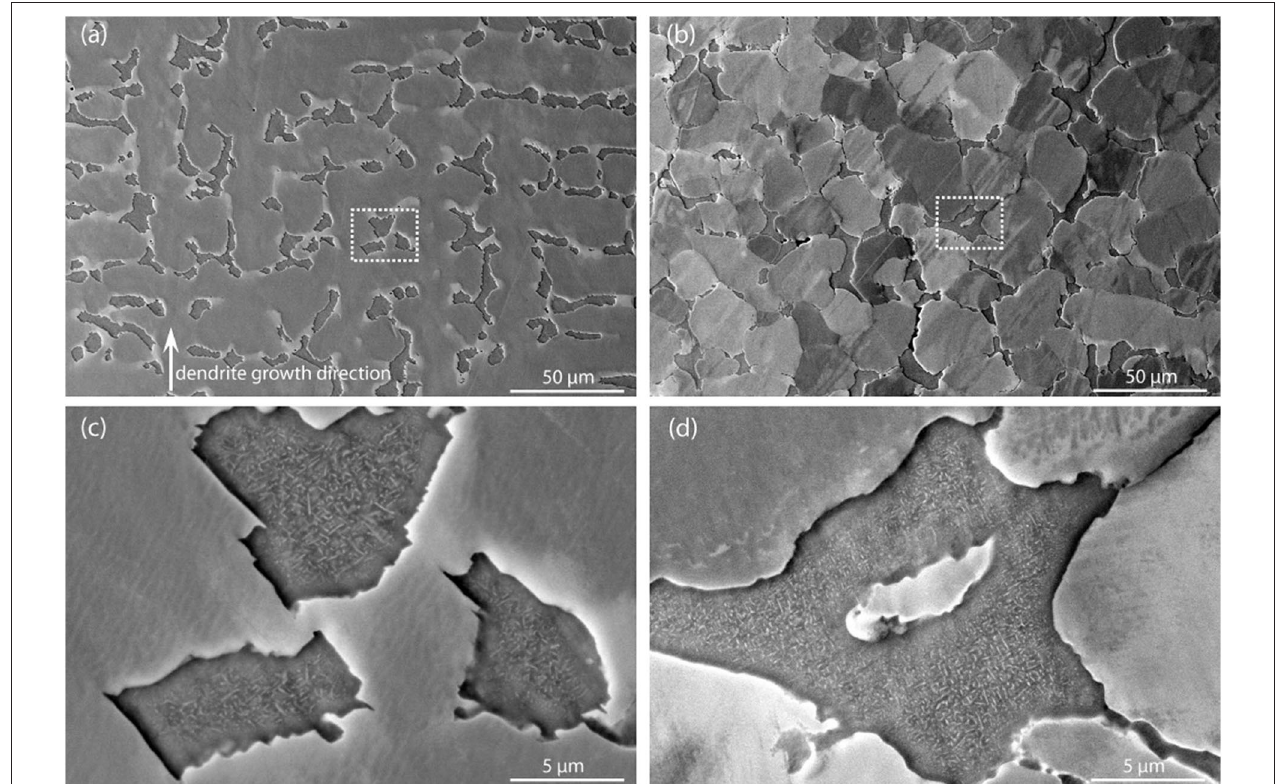
FIGURE 1 | As cast microstructures: (a) columnar zone and (b) equiaxed zone of the ingot. (c,d) shows higher magnification images of the interdendritic regions corresponding to the dashed rectangles in (a,b) ,